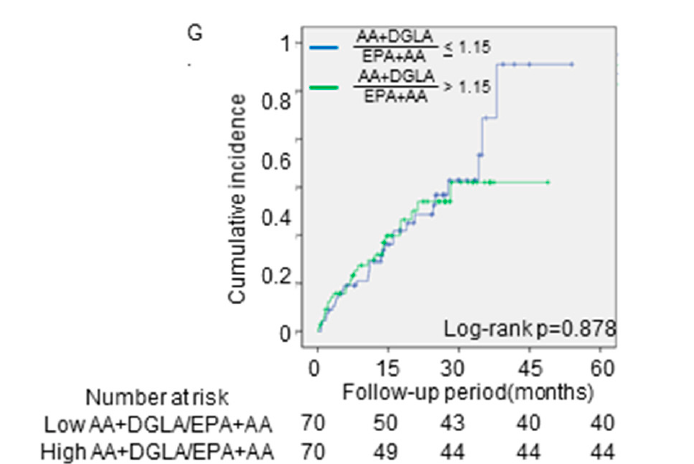
Figure 4. The associations between the secondary outcomes and PUFA levels. The cumulative incidences of the secondary endpoints (cardiac death and re-hospitalization for heart failure) were estimated by using the Kaplan–Meier method. Log-rank testing was performed to study the influence of PUFA levels on primary endpoint. The patients were divided into two groups, based on the median levels of ( A ) EPA, ( B ) DHA, ( C ) AA, ( D ) DGLA, and ( E ) EPA/AA, ( F ) DHA/AA, and ( G ) AA + DGLA/EPA + DHA. PUFA, polyunsaturated fatty acid; EPA, eicosapentaenoic acid; DHA, docosahexaenoic acid; AA, arachidonic acid; DGLA, dihomo-gamma-linolenic acid; EPA/AA, ratio of EPA to AA; DHA/AA, ratio of DHA to AA; AA + DGLA/EPA + DHA; ratio of AA + DGLA to EPA +